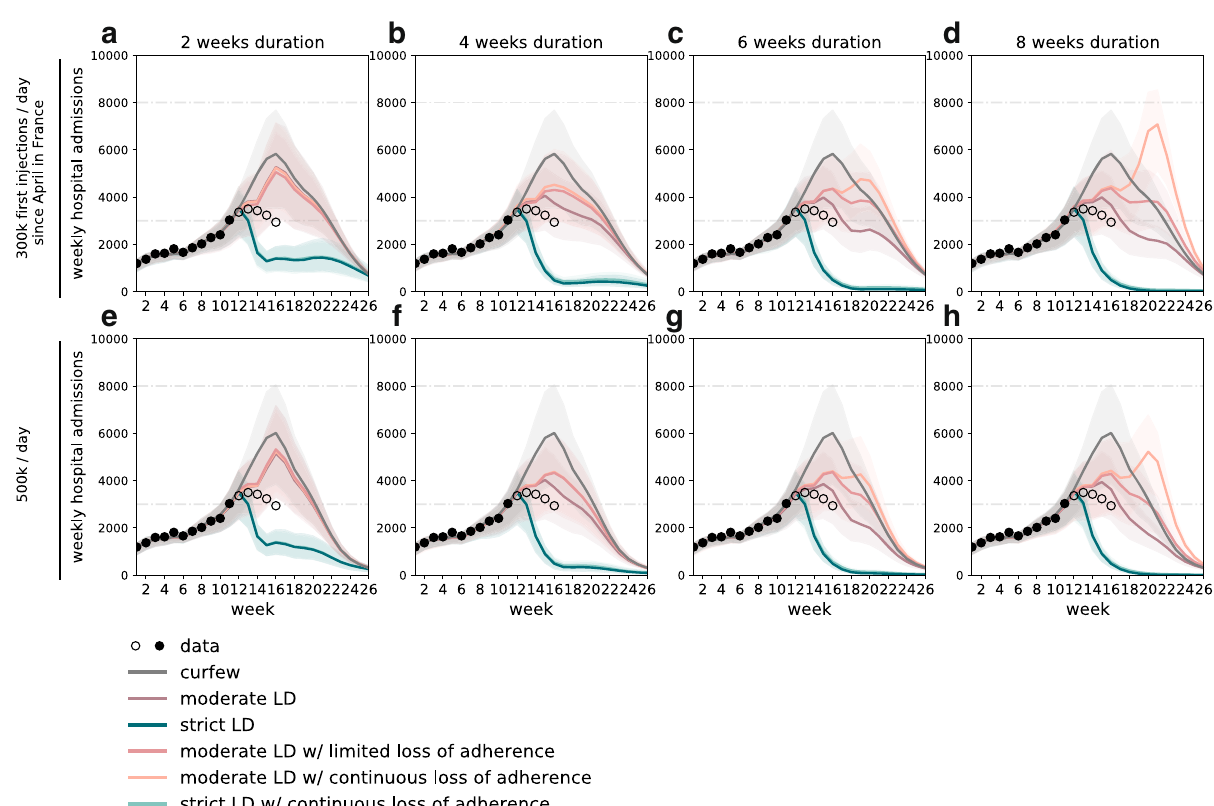
Fig. 2 Timecourse of weekly hospital admissions in Île-de-France for lockdown scenarios of varying stringency, duration, and adherence. a – d : vaccination pace accelerated to 300,000 fi rst doses/day since the start of April, lockdown duration of two ( a ), four ( b ), six ( c ), or eight ( d ) weeks.; e – h : as in a – d , but assuming 500,000 fi rst doses/day. Interventions are applied in w12 and assume a delay of one week to the peak in hospital admissions. Dots refer to data; fi lled dots correspond to the data used to fi t the model and to provide the trajectory for the curfew scenario; void dots correspond to more recent data. Curves refer to the median trajectory; shaded areas around the curves correspond to the 95% probability ranges obtained from n = 250 independent stochastic simulations. The type of intervention is coded by different line colors; the abbreviation LD stands for lockdown. Horizontal dashed lines refer to the peak of the fi rst and second wave in the region. Results for 2 weeks lockdown scenarios with or without loss of adherence overlap, as loss of adherence occurs in the third week. Results for strict lockdown scenarios with full adherence or loss of adherence overlap; for this reason, we do not show the scenario with limited loss of